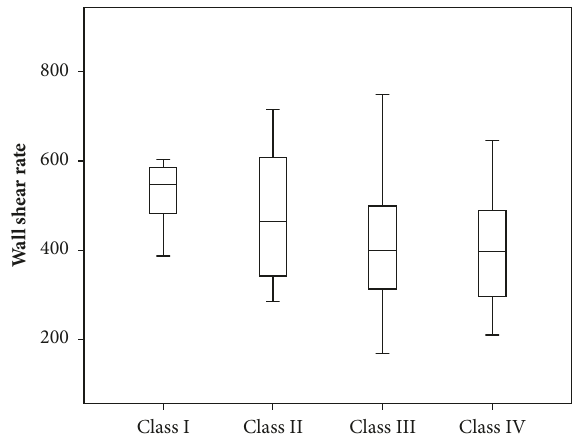
Figure 1: Wall shear rate in patients in different groups of patients.